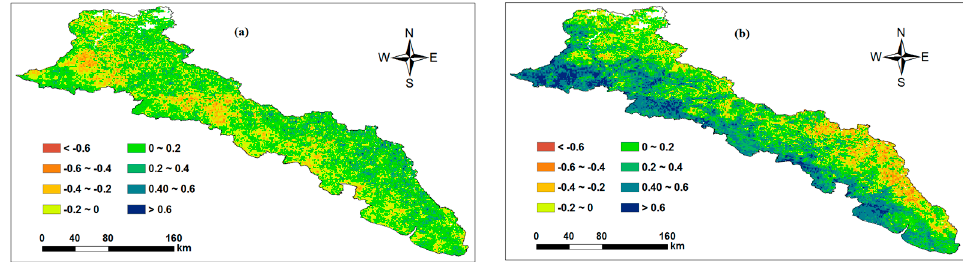
Figure 7. Correlation of vegetation GPP with temperature ( a ) and precipitation ( b ) in the Altay